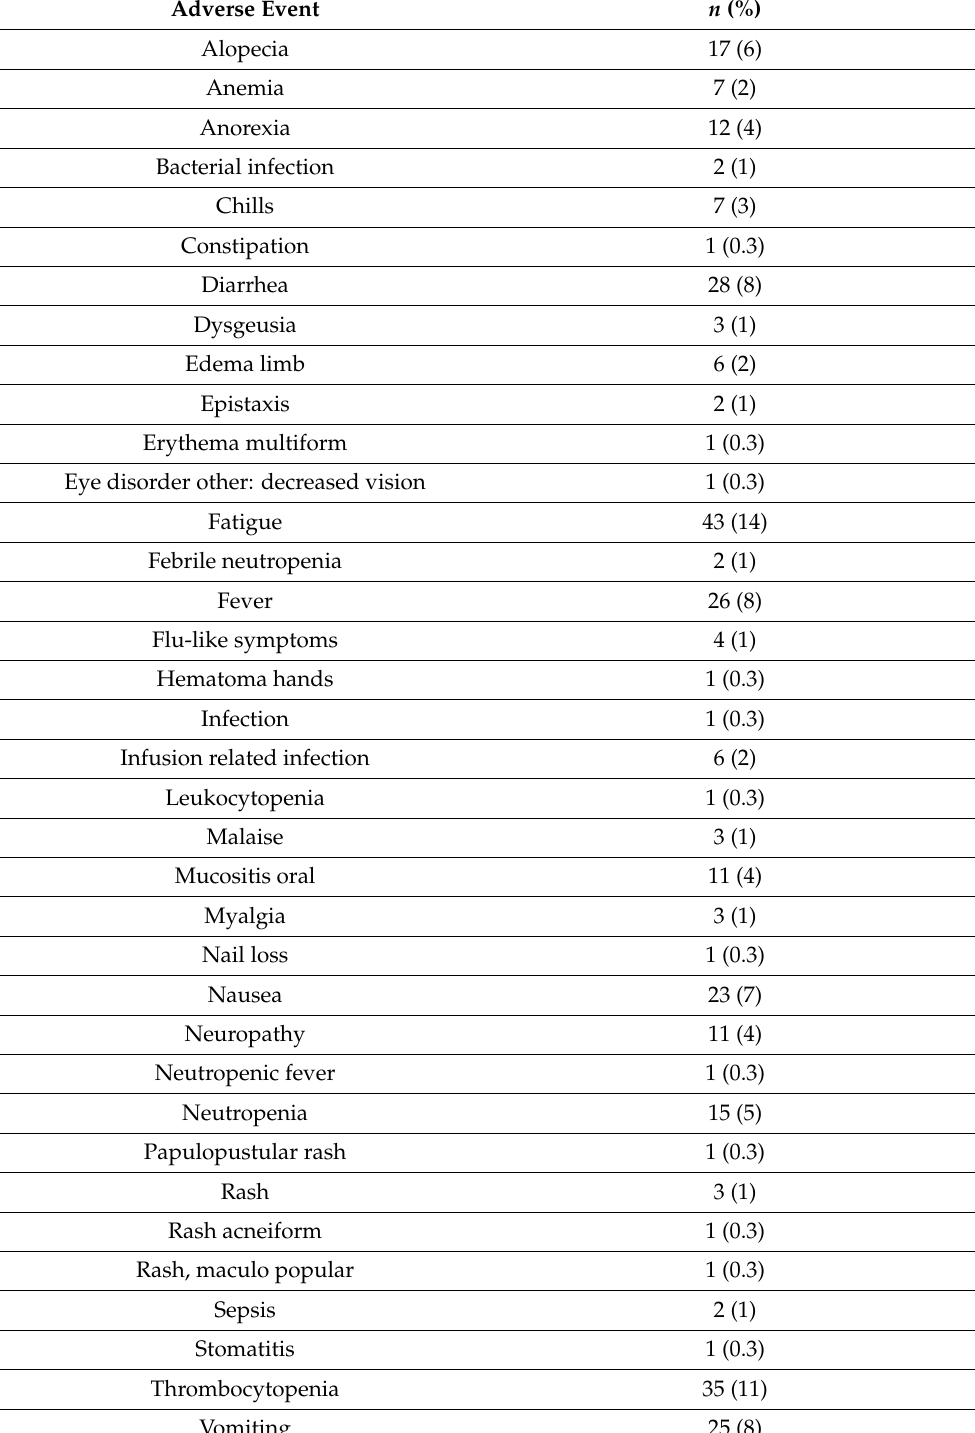
Table 4. Adverse events phase I and II combined (all the patients that received prior treatment with FOLFIRINOX and treatment with LDE225 200 mg); possible, probable or definitely treatment related. Adverse Event n (%) Alopecia 17 (6) Anemia 7 (2) Anorexia 12 (4) Bacterial infection 2 (1) Chills 7 (3) Constipation 1 (0.3) Diarrhea 28